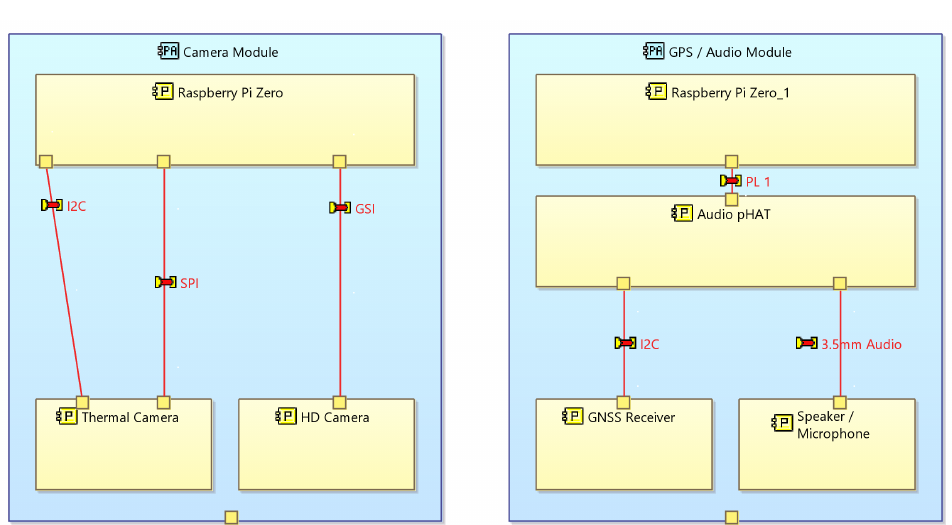
Figure 3. The K9 Vest Camera and Localisation/Audio